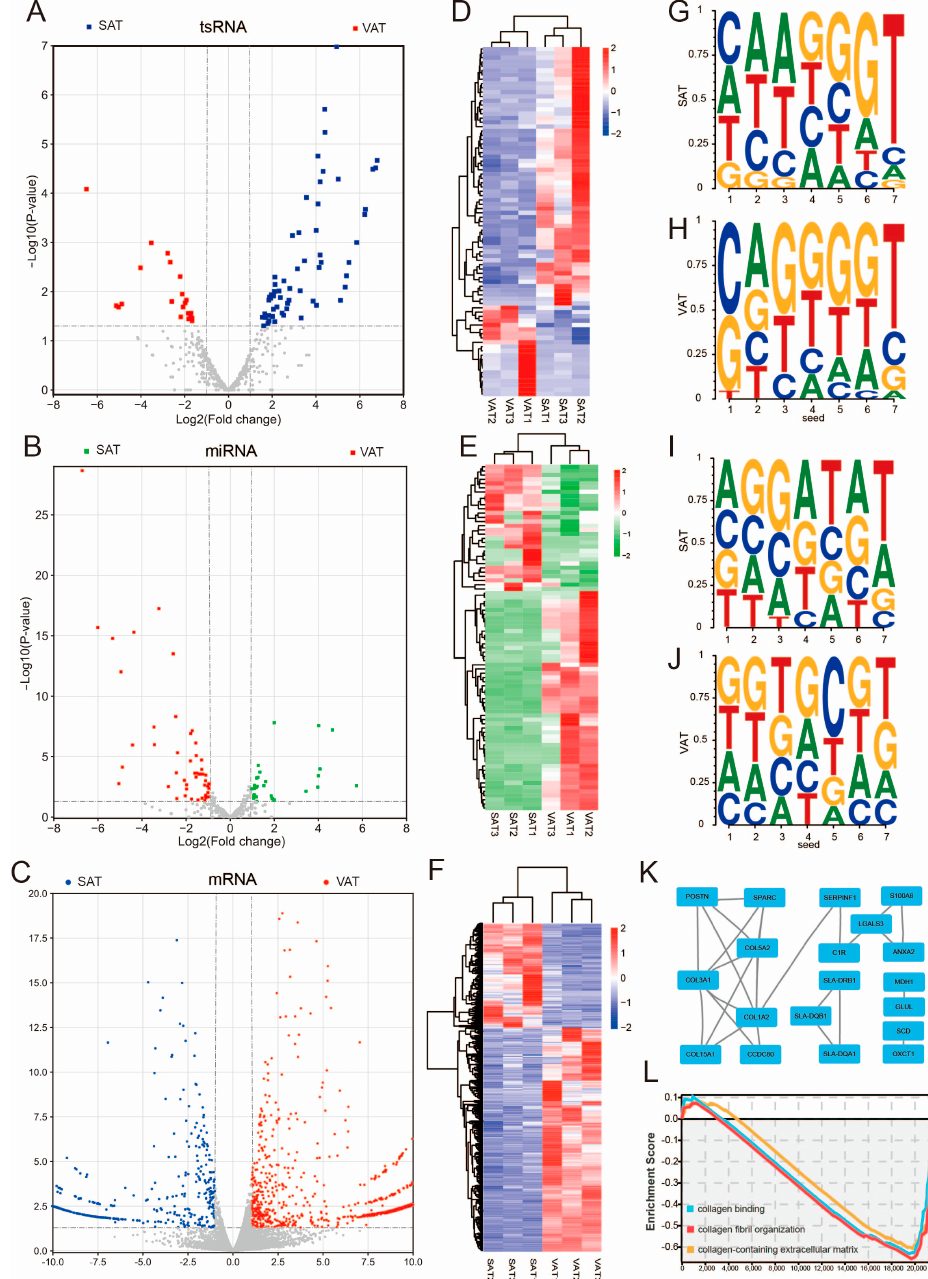
Figure 4. Differential analysis of tsRNAs, miRNAs, and mRNAs in SAT and VAT. ( A – C ) Volcano plots showing the tsRNAs ( A ), miRNAs ( B ), and mRNAs ( C ) differentially expressed in SAT and VAT. ( D – F ) Cluster analysis of the differentially expressed tsRNAs ( D ), miRNAs ( E ), and mRNAs ( F ). ( G , H ) Sequence features of seed sequences that highly express tsRNAs in either SAT ( G ) or VAT ( H ). ( I , J ) Sequence features of seed sequences that highly express miRNAs in either SAT ( I ) or VAT ( J ). ( K ) PPI (protein–protein interaction) network analysis of highly expressed and differentially expressed mRNAs in SAT and VAT. ( L ) GSEA of the signaling pathways associated with collagen.